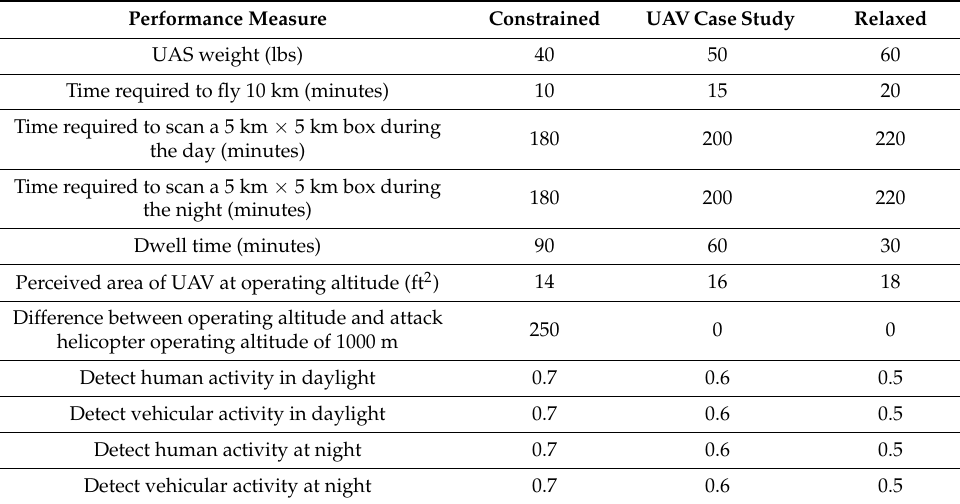
Figure 8. Effects of Requirements on the UAV’s Feasible Tradespace [43]. Table 2. UAV Case Study with Relaxed, Original, and Constrained Requirements.